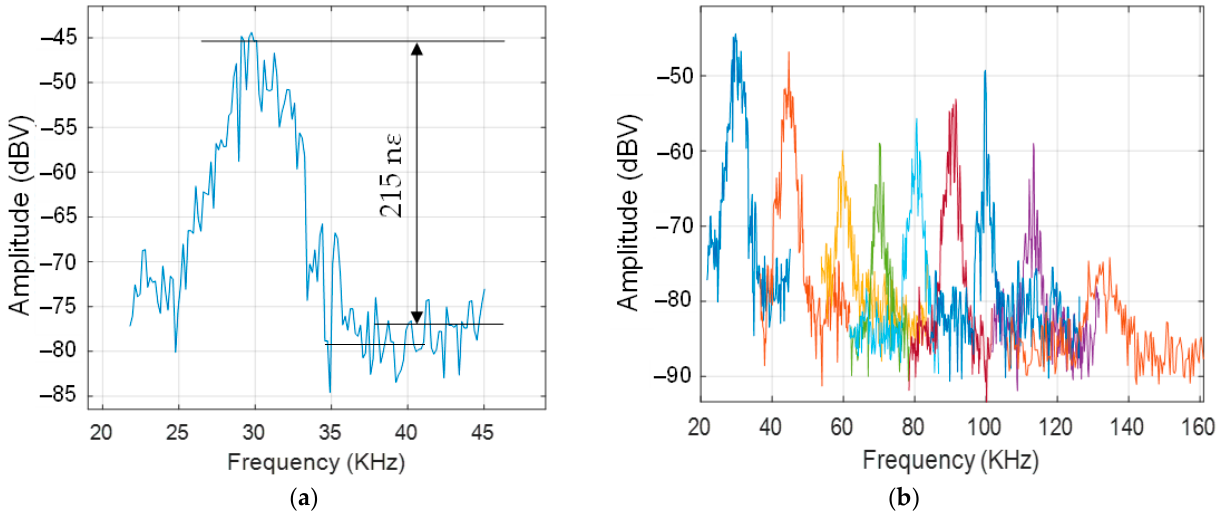
Figure 13. Detected vibration signals after the lock-in amplification stage: ( a ) calibrated measurement of the FBG dynamic strain at 30 kHz equivalent to 0.1 rad over a 10 cm length of fiber; ( b ) frequency sweep of the mechanical vibration.